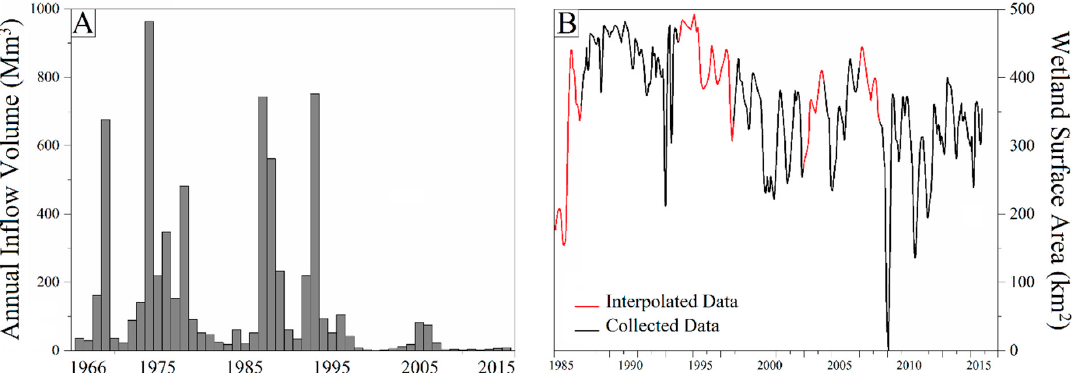
Figure 4. Wetland Gavkhuni. ( A ): The annual inflow volume to the Gavkhuni Wetland, in (Mm 3 ) for 1966–2015. ( B ): the wetland area fluctuation (km 2 ) for 1985–2015, missing or uninterpretable were interpolated and are shown in red in ( B ).